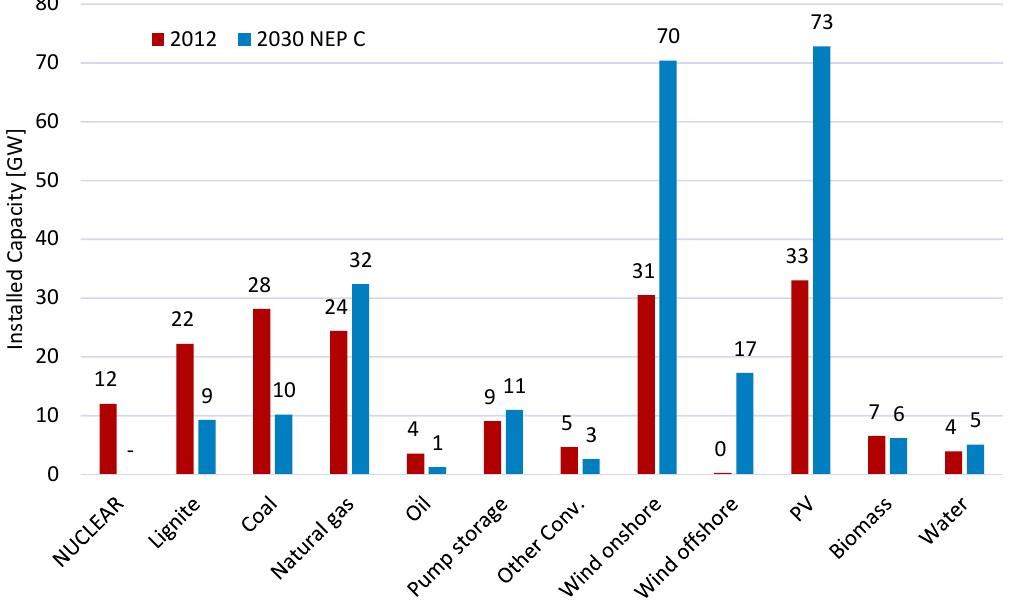
Figure 4. Aggregated power production capacities for Germany in 2012 vs. 2030 NEP C. Source: authors’ assumptions based on [44].